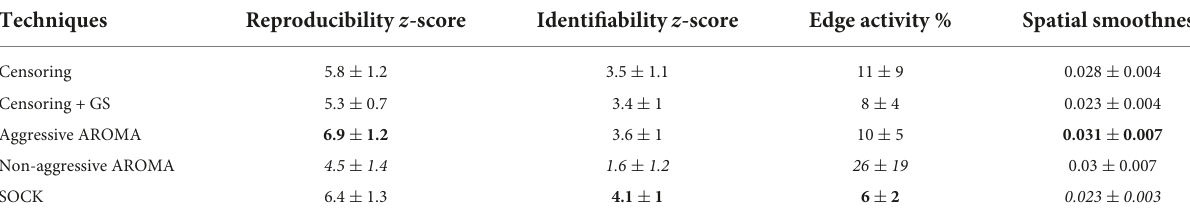
TABLE 2 RSN data quality metrics based on data across all scanners collected from the rrAD project.